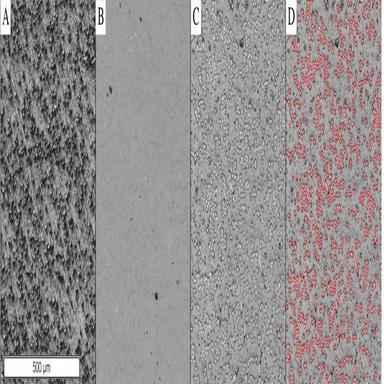
Progression of the surface after (A) rough polishing, (B) final polishing, (C) plasma etching, and (D) post-processing with elliptical fits around the crosssection of each fiber.